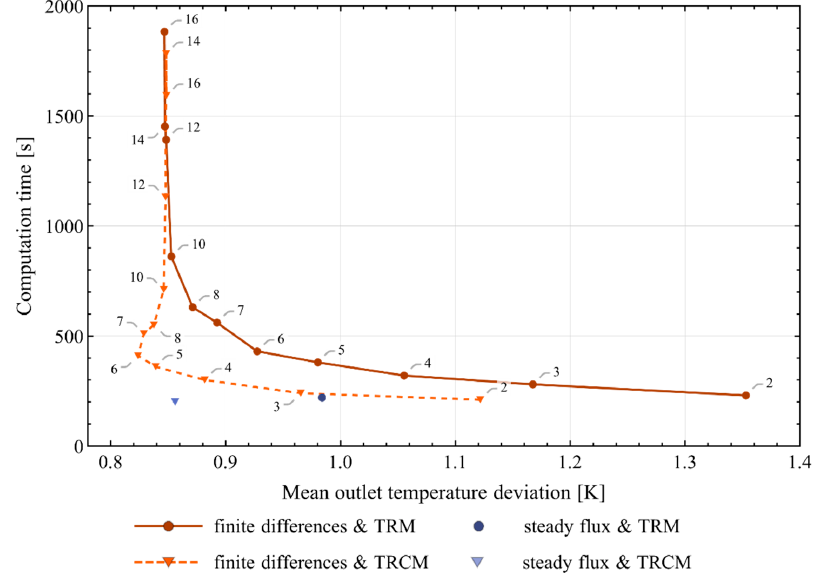
Figure 9. Computation time and mean deviation of the outlet temperature in comparison to the Brædstrup monitoring data for different local models. FDM models are labeled with their according number of used capacity nodes.